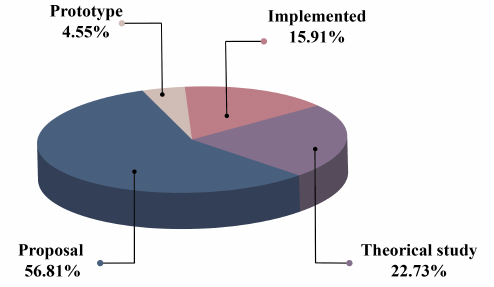
Figure 4. Type of presented work.